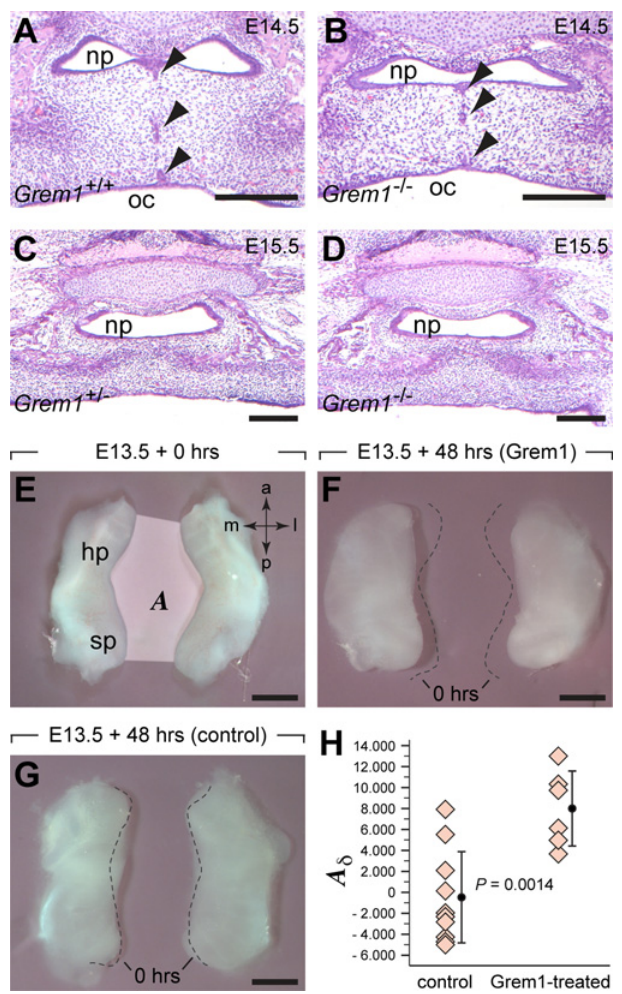
hard palate, the palatal shelves have fused and epithelial rests (arrowheads) are seen in both Grem1 +/+ ( A ) and Grem1 -/- ( B ) embryos at E14.5. At E15.5, the soft palate has fused in both Grem1 +/- ( C ) and Grem1